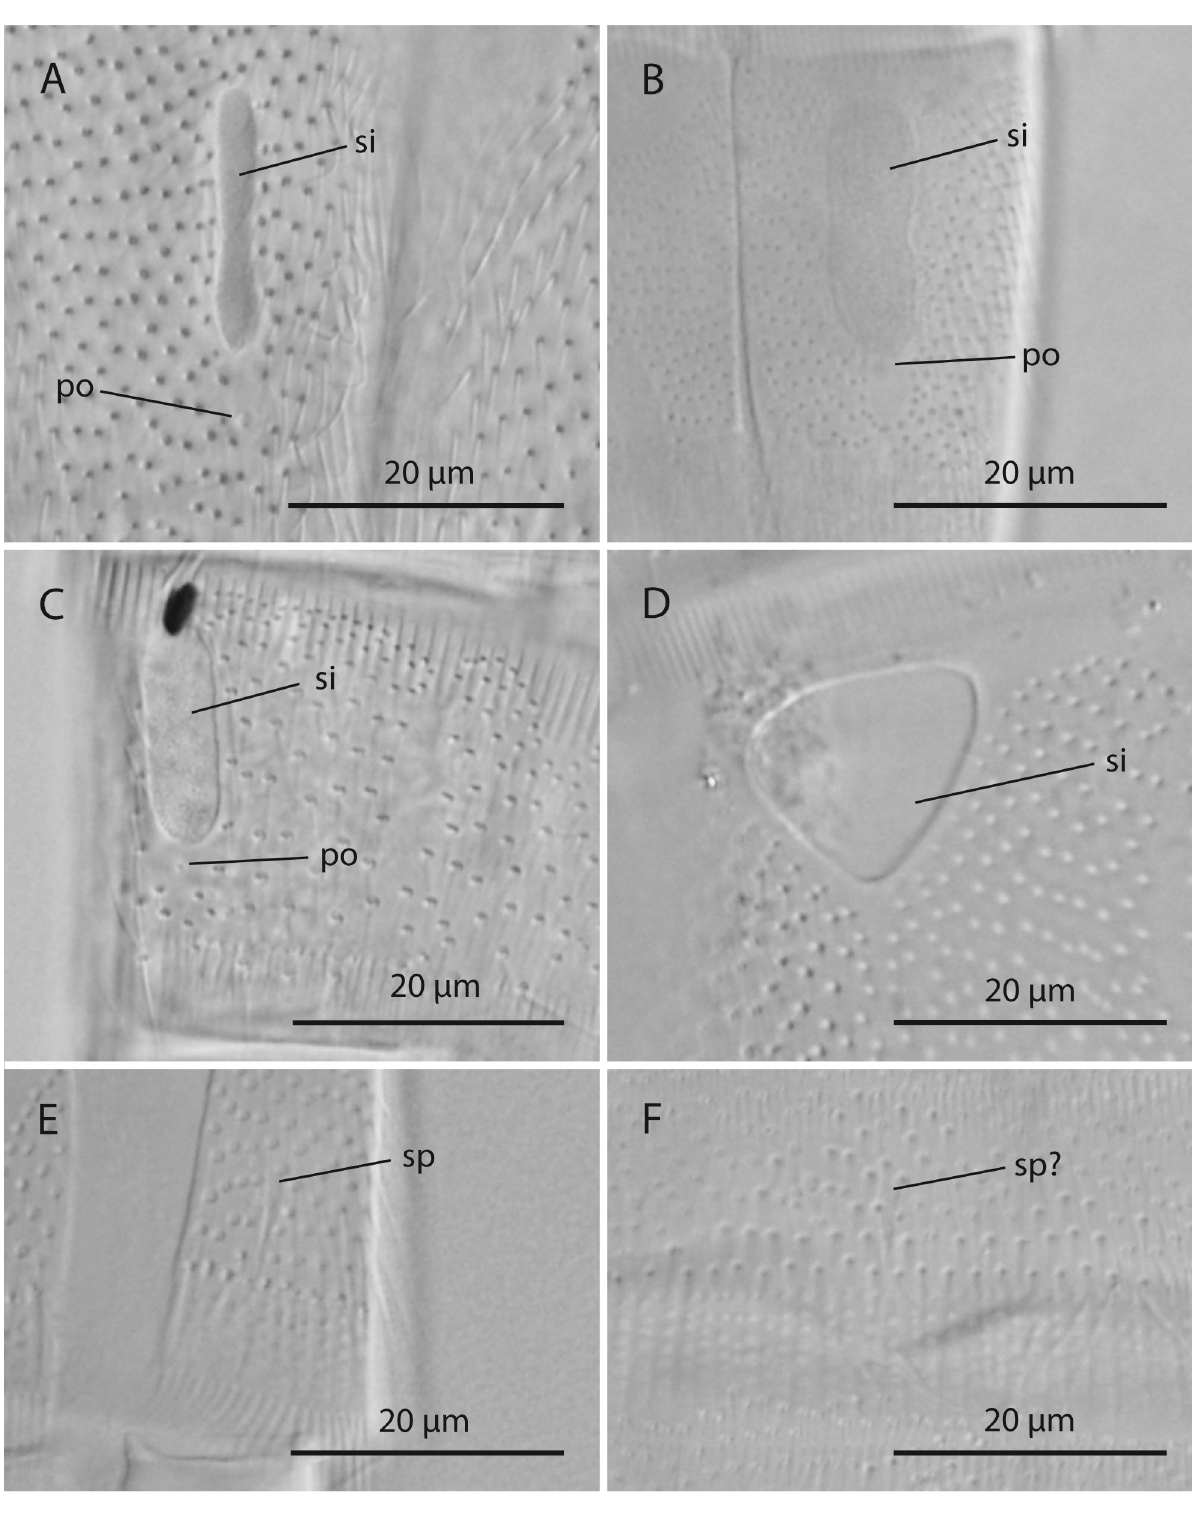
Fig . 4. – Light microscope photos showing cuticular details in selected species of Echinoderes . A, sieve plate in Echinoderes rex n. sp. female, segment 9, lateral view; B, sieve plate in female E. coulli type II, USNM 54388, segment 9, lateral view; C, sieve plate in female E. teretis , ZMUC KIN-454, segment 9, lateral view; D, sieve plate in female E. maxwelli , 12.22.2., segment 9, lateral view; E, male E. maxwelli , 12.22.1., segment 6, lateroventral spine; F, male E. maxwelli, 12.22.1., detail from middorsal position of segment 4, showing weak indications of a feebly visible spine. Abbreviations: po, pore; si, sieve plate; sp,